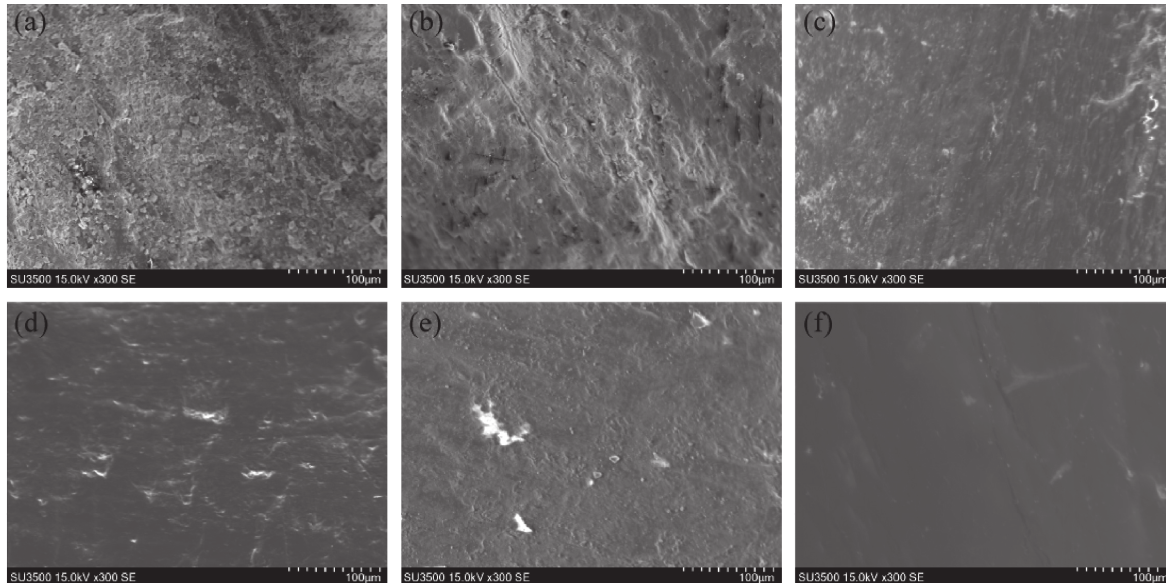
Figure 6: SEM images of different coal samples at a magnification factor of 300: (a) lignite; (b) gas coal; (c) fat coal; (d) coking coal; (e) meager-lean coal; (f) anthracite.